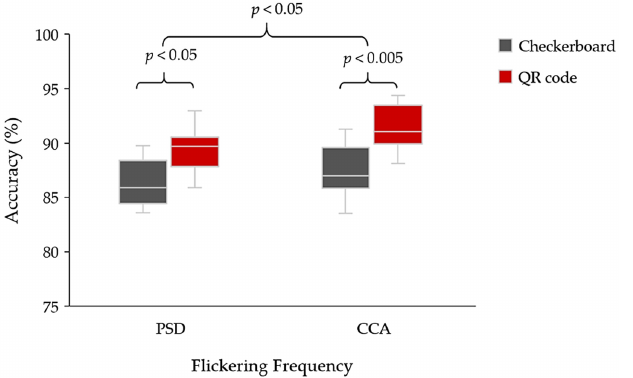
Figure 11. Average classification accuracy between the checkerboard and QR code patterns of SSVEP stimulus for the PSD and CCA methods.